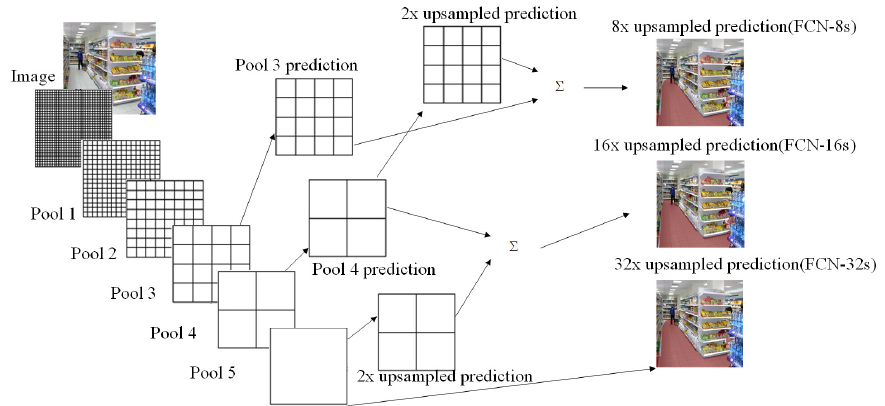
Figure 1. Fully convolutional network